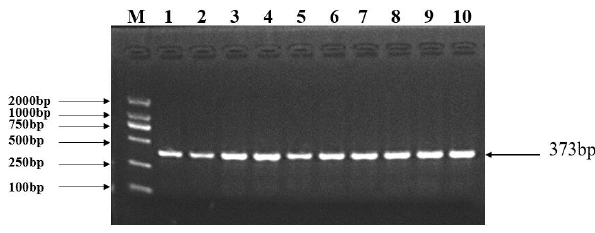
Figure 2. PCR amplification of MAP3K5 . Lanes 1–10: target frag- ments; M : DL2000 DNA